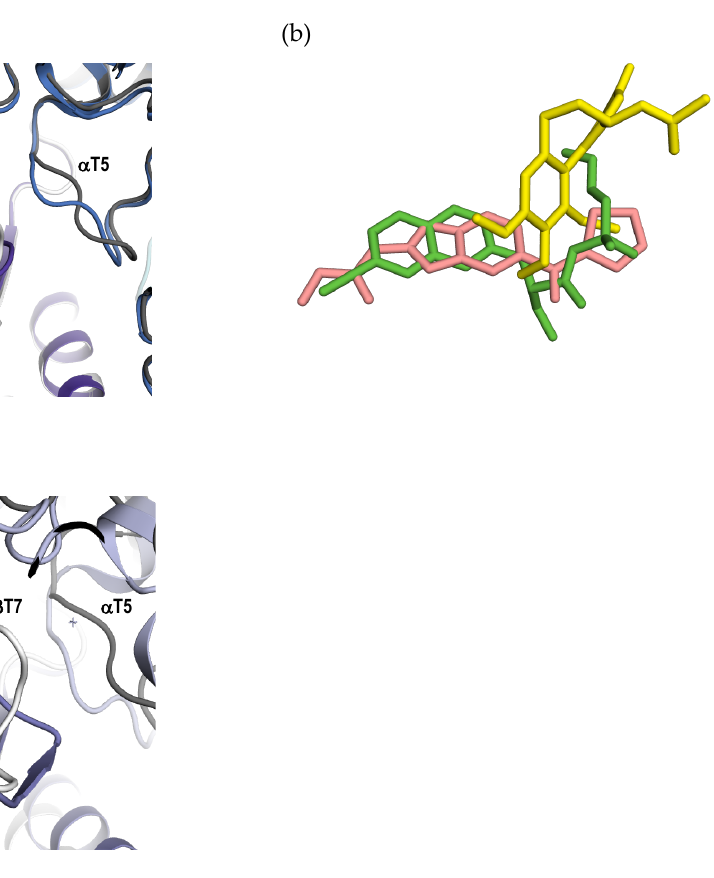
Figure 6. Mechanism of QA 1- mediated microtubule destabilization. ( a ) Superimposition of tubulin in its QA 1 bound ( white ribbons, β -tubulin; grey ribbons, α -tubulin) and unliganded ( purple ribbons, β -tubulin; blue ribbons, α -tubulin). The β -tubulin subunits were used for the superimposition. QA is displayed as green sticks; ( b ) Superimposition of QA 1 ( green sticks) with colchicine ( yellow sticks, PDB ID 4O2B) and nocodazole ( pink sticks, PDB ID 5CA1); ( c ) Superimposition of QA 1 bound “curved” tubulin ( white ) with “straight” tubulin in microtubules ( purple ). QA 1 is displayed as green sticks. Oxygen and nitrogen atoms are displayed in red and blue,